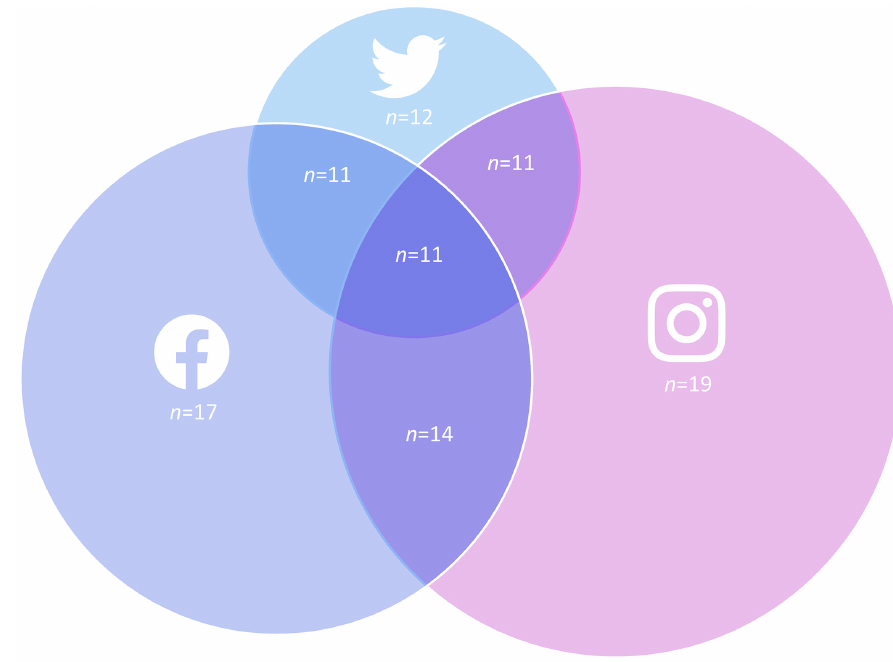
Figure 1. What social media platform do you follow Greta Thunberg on (Instagram, Facebook, Twitter)? Media and Communication, 2022, Volume 10, Issue 2, Pages